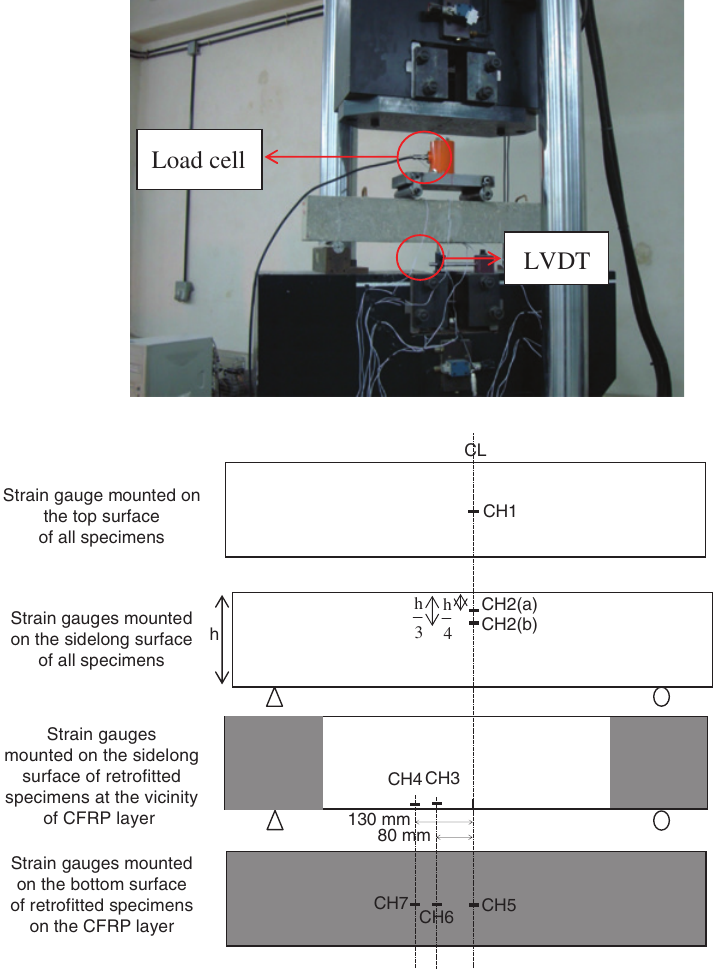
Figure 3: Fatigue test setup and position of strain gauges mounted on all the